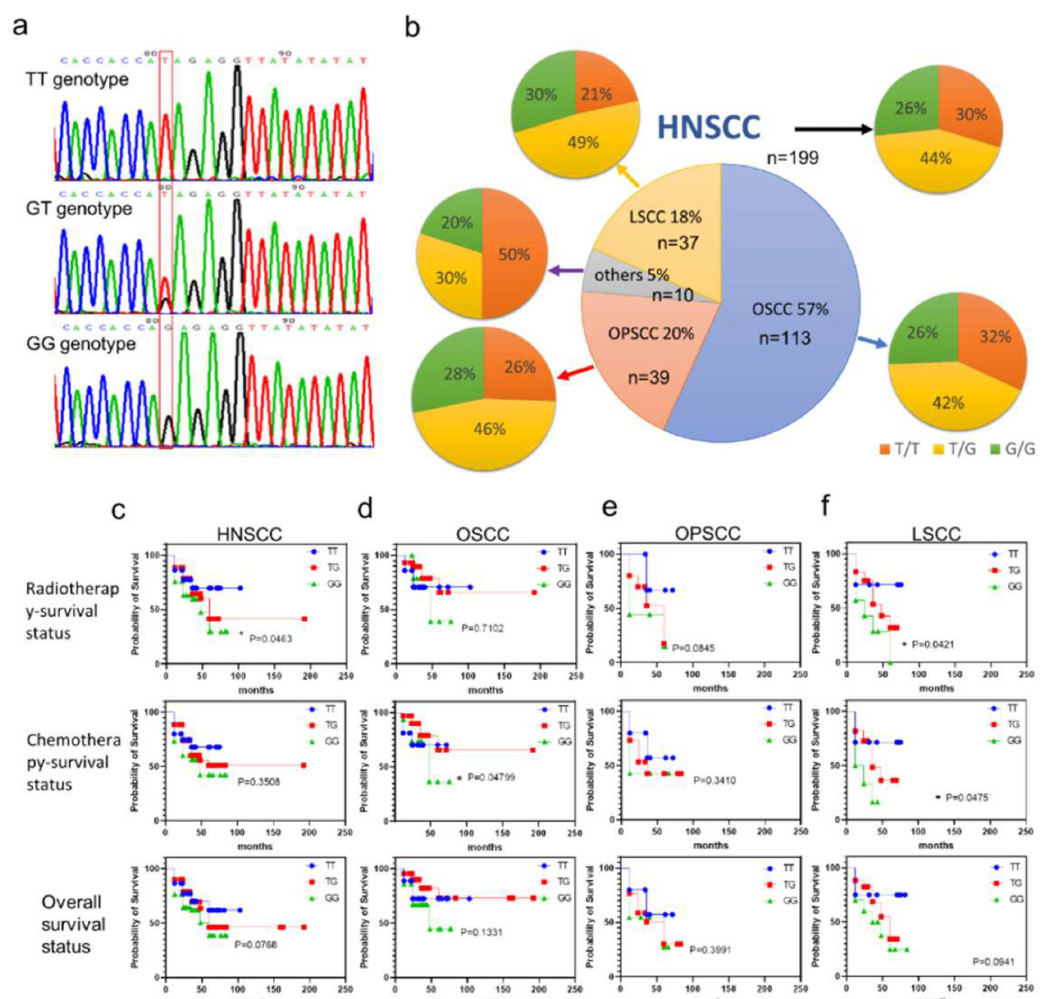
Figure 1. Relation between the GALNT14 -rs9679162 genotype and radiotherapy, chemotherapy, and overall survival in HNSCC cases and its subtypes. GALNT14 -rs9679162 sequencing and genotype frequency in HNSCC. ( a ) Direct sequencing of PCR products of GALNT14 -rs9679162. The red box indicates TT, GT, and GG genotypes. ( b ) Genotype frequency of GALNT14 -rs9679162 in 199 HNSCC, 113 OSCC, 39 OPSCC, 37 LSCC, and 10 other cancer subjects. Large pie chart; n, sample size in each type of cancer; percentage, percentage of each subtype of cancer in HNSCC. Small pie chart; orange, yellow, and green indicate the percentage of TT, TG, and GG genotypes in each type of cancer. Survival curves of patients exhibiting TT, TG and GG genotypes in ( c ) HNSCC, ( d ) OSCC, ( e ) OPSCC, and ( f ) LSCC. Log-rank test; * p <